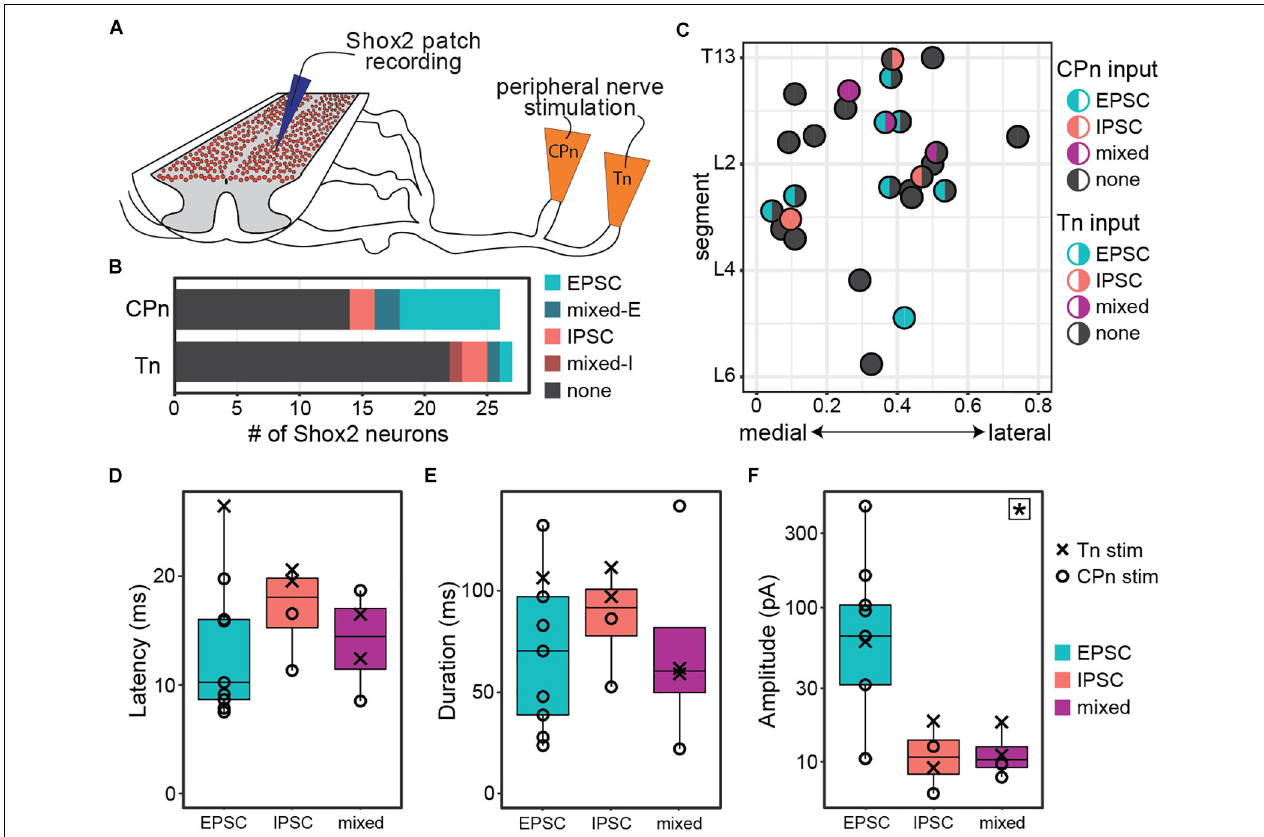
FIGURE 2 | Both common peroneal and tibial nerve stimulation can induce postsynaptic currents in Shox2 neurons. (A) Cartoon of ventral horn-removed spinal cord preparation with intact sciatic nerve branches for stimulation of common peroneal (CPn) and tibial nerves (Tn). (B) The proportion of excitatory, inhibitory, mixed-E, and mixed-I currents detected in Shox2 neurons following CPn stimulation and following Tn stimulation. (C) Shox2 neurons recorded during stimulation of both CPn and Tn are plotted according to anatomical position and color-coded based on response type. Segment number corresponds to the center point of the dorsal root at the entry zone. Shox2 neurons displaying postsynaptic currents to CPn and Tn stimulation were observed throughout the lumbar cord. (D–F) Latency, duration and amplitude plotted for each response subtype. Mixed-E and mixed-I responses were pooled into a single mixed subtype. Latency and duration did not significantly differ between evoked excitatory, inhibitory or mixed currents, whereas peak amplitude differed significantly between current types ( p = 0.027, indicated by star in upper right corner). Post hoc testing did not detect significant pairwise comparisons when corrected for multiple comparisons (see text for details). Amplitude plotted on log scale for